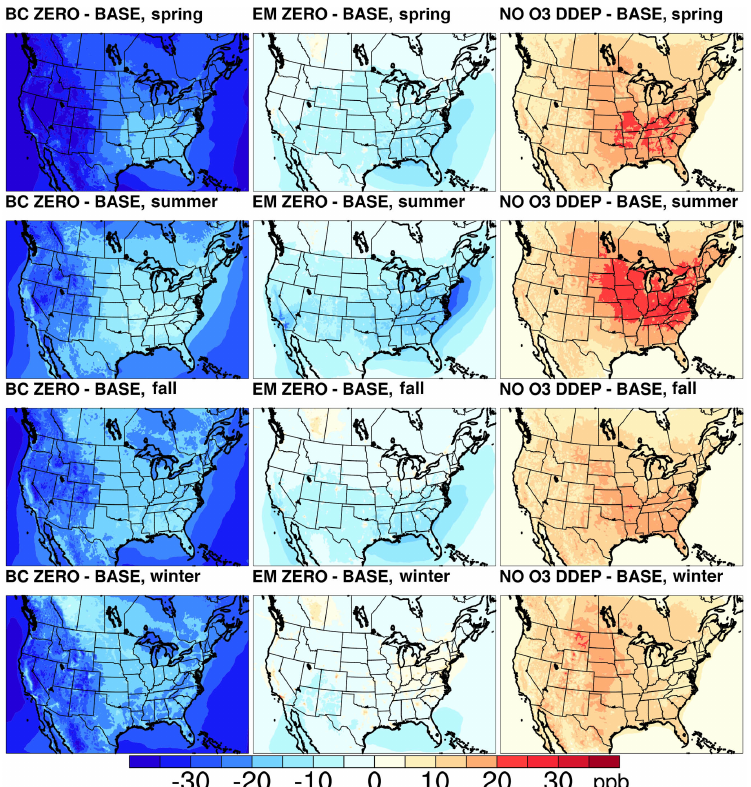
Figure 7. Maps of differences in seasonal mean ozone mixing ratios between the three sensitivity simulations (BC ZERO, EM ZERO, and NO O3 DDEP) and the BASE